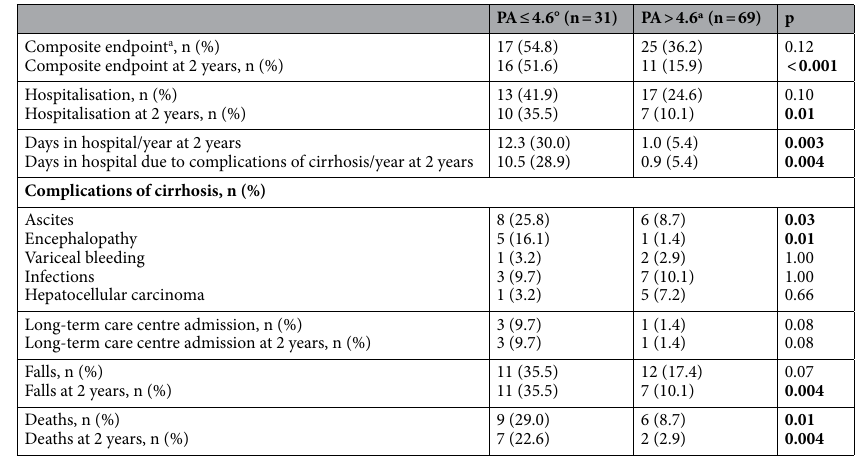
Table 3. Adverse outcomes during follow-up in patients with phase angle (PA) ≤ 4.6° and patients with PA > 4.6°. Data are expressed as frequencies and percentages, or mean (SD). P values in bold indicate statistical significance (p < 0.05). a Endpoint including hospitalisation, long-term care centre admission, falls, or death.